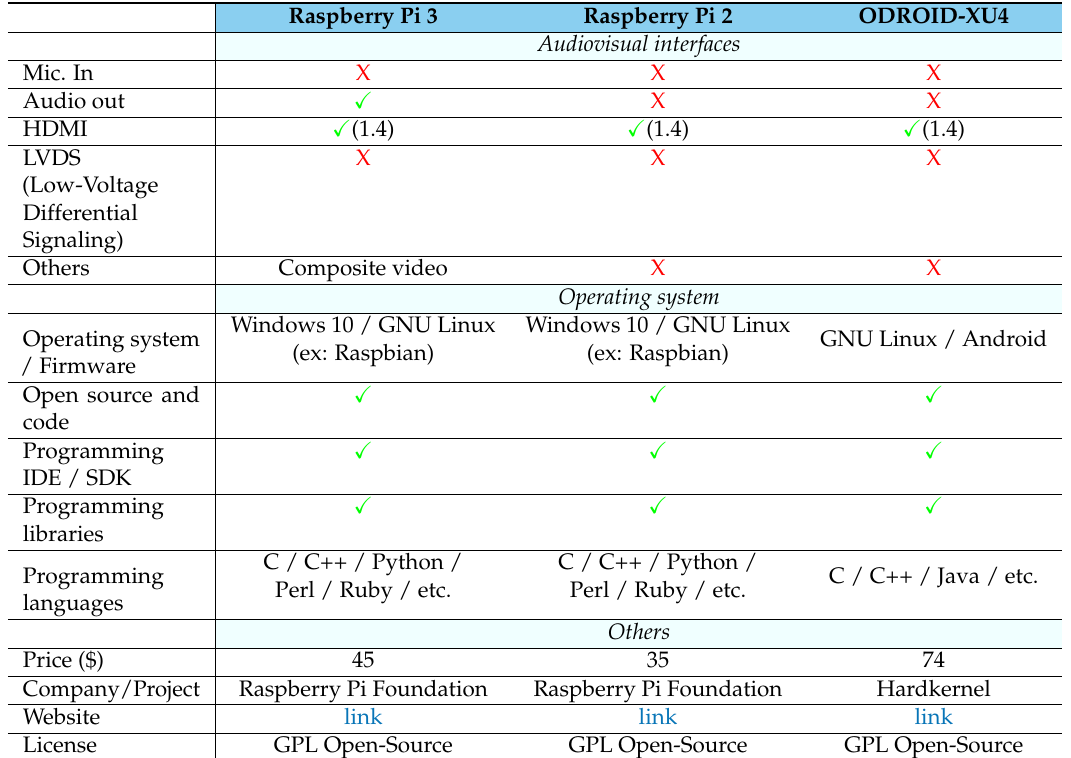
Table 9. OnBoardComputer candidates